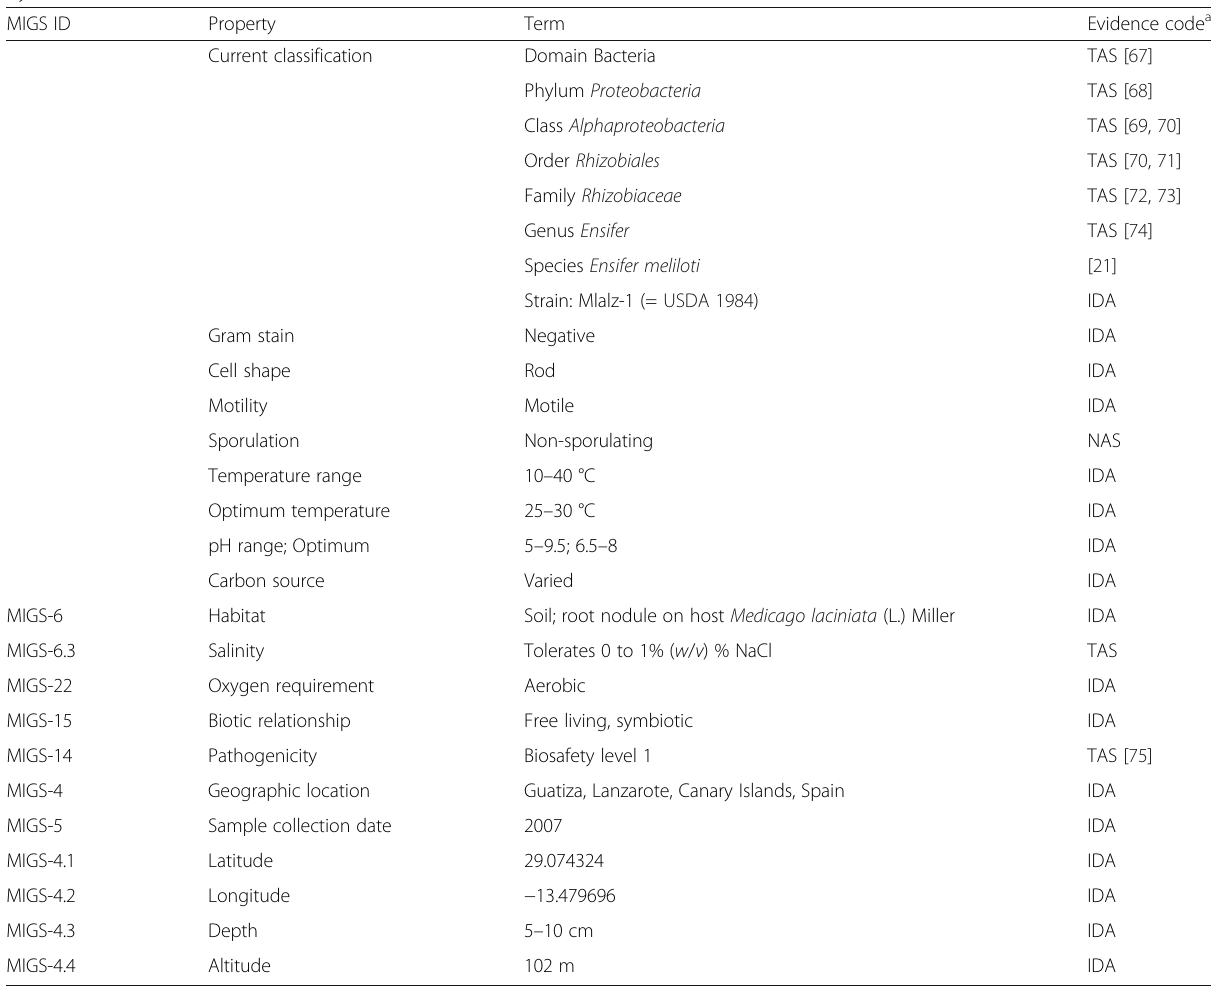
Table 1 Classification and general features of Ensifer meliloti Mlalz-1 in accordance with the MIGS recommendations [65] published by the Genomic Standards Consortium